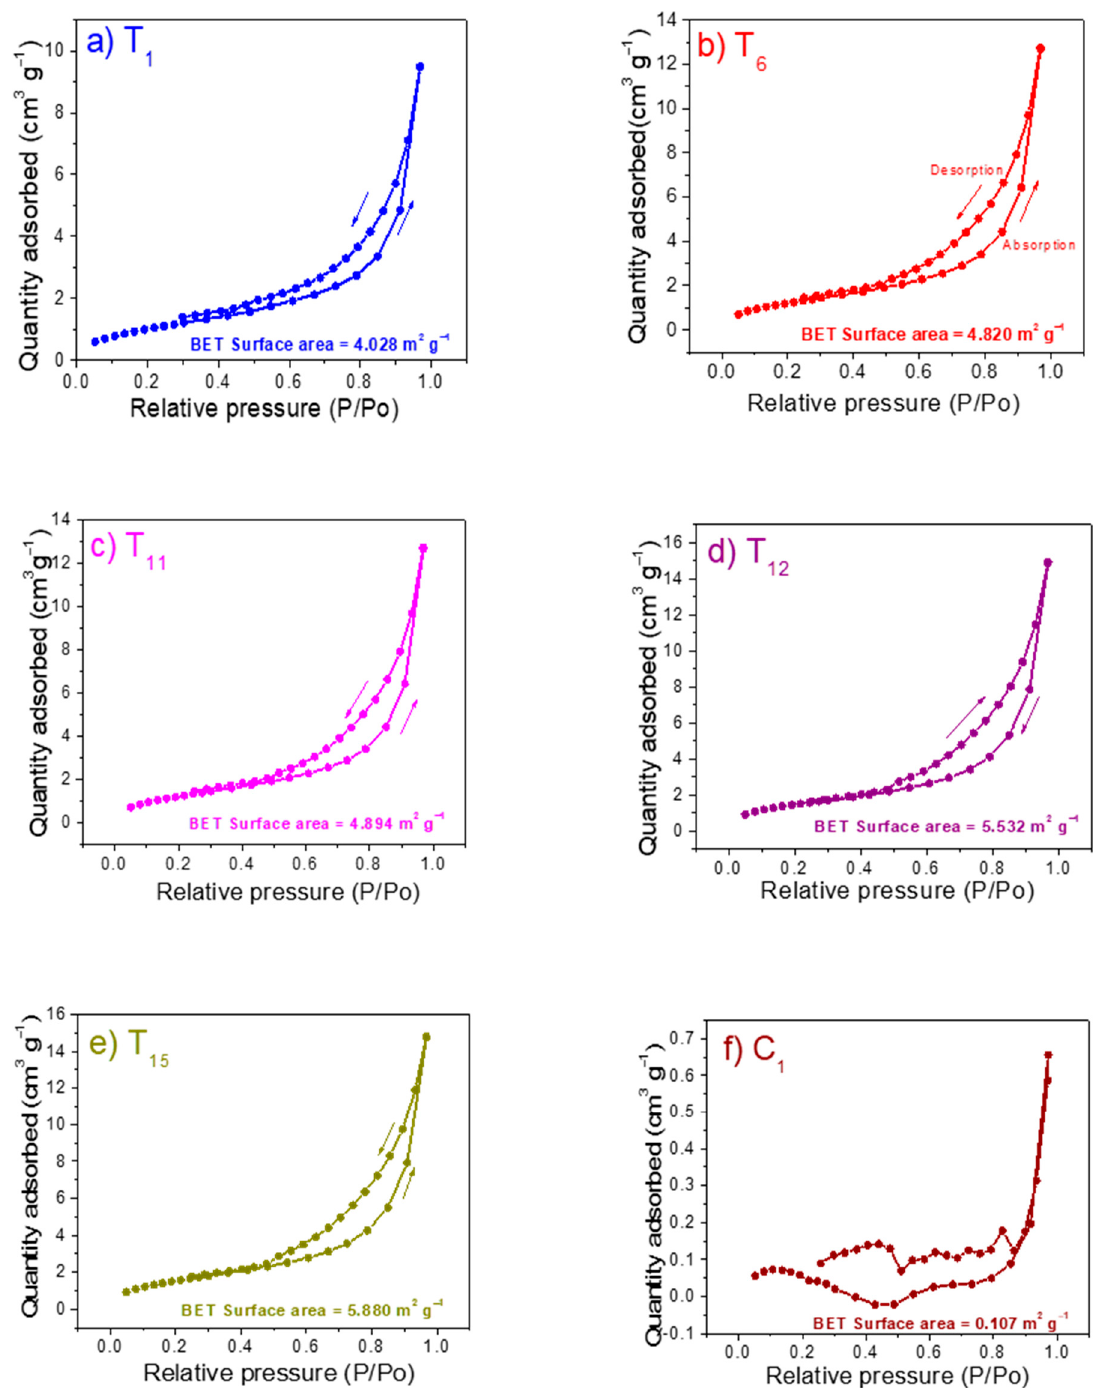
Figure 5. N 2 adsorption-desorption isotherms and pores size distributions of as-prepared samples ( a ) T 1 , ( b ) T 6 , ( c ) T 11 , ( d ) T 12 , ( e ) T 15 , and control ( f ) C 1 .